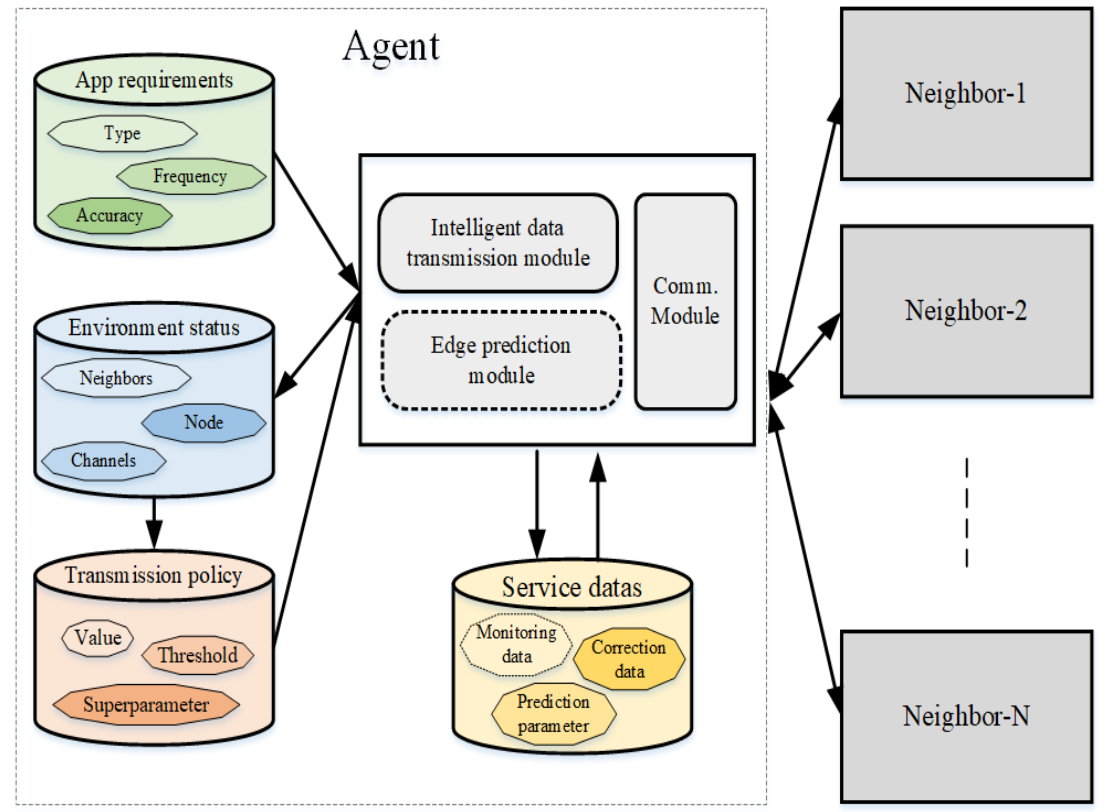
Figure 2. Agent model of underwater wireless sensor network.